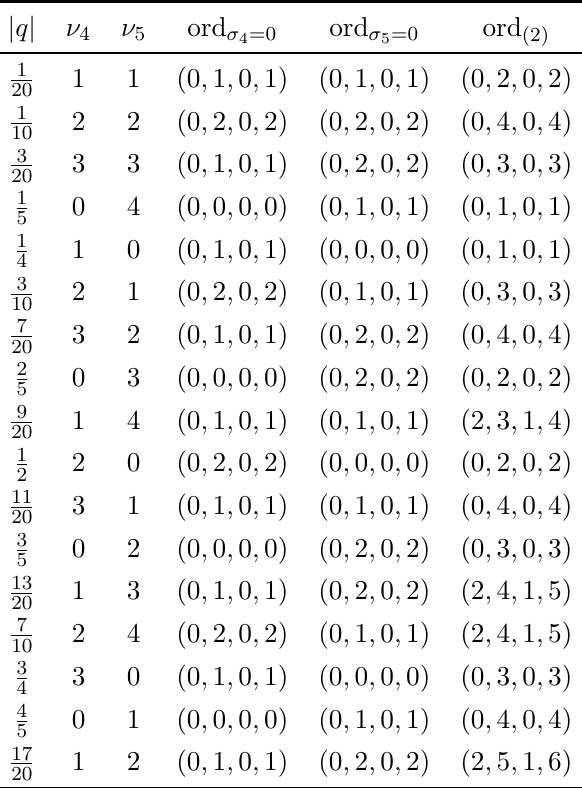
Table 23. Orders of vanishing for (ˆ x, ˆ y, ˆ z, ˆ w ) at codimension one and two for combinations of ν 4 , ν 5 , and pseudo-charge q for ( 4 , 5 ) bifundamental matter. These data are found using